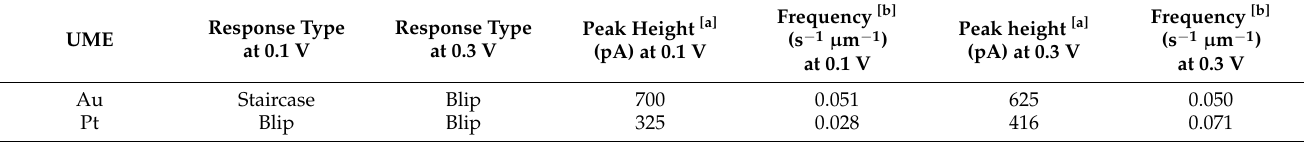
Table 1. Response types, peak heights, and frequencies of single-Pd-NPs collisions at Au and Pt UMEs obtained during the chronoamperometric measurements at 0.1 and 0.3